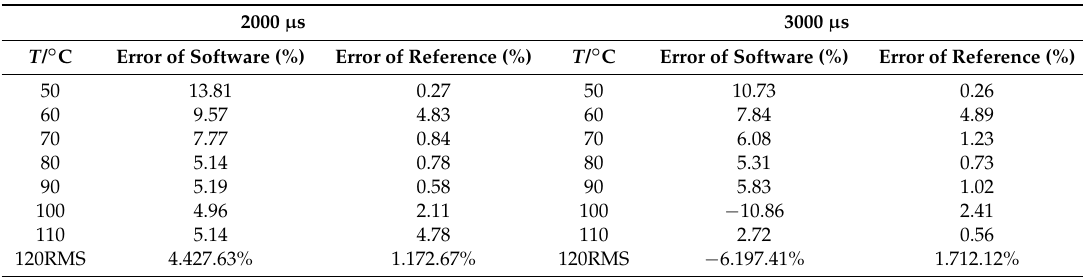
Table 2. The radiometric error at 2000 µ s and 3000 µ s 1